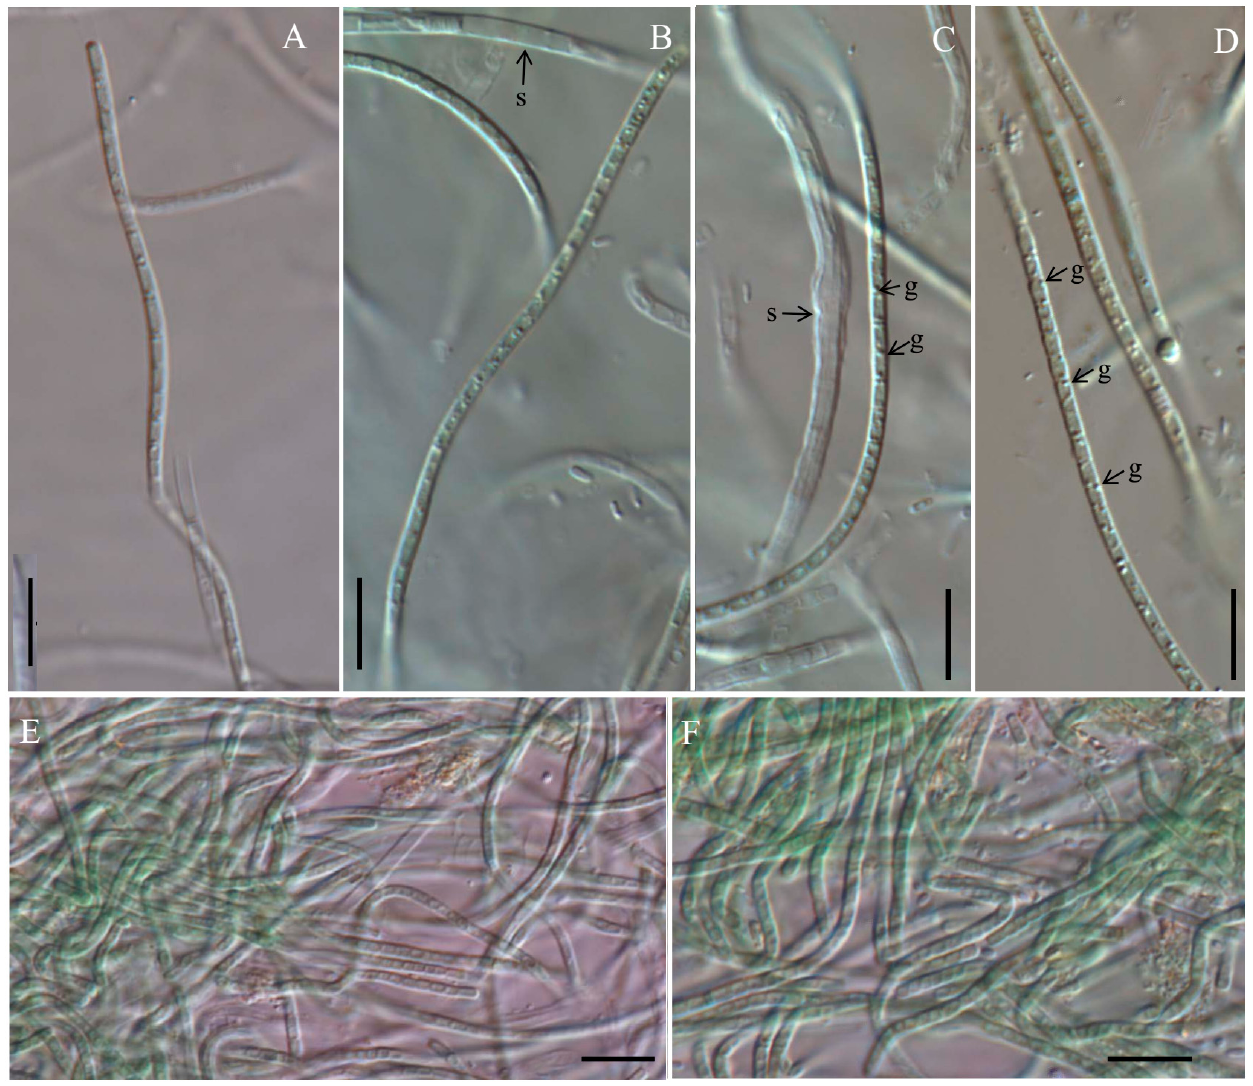
Figure 1. Micrographs of Cartusia hunanesis by light microscopy (LM): ( A , B , E ) Cartusia hunanesis ZJJ02; ( C , D , F ) Cartusia hunanesis ZJJ03. s: sheath, g: granules. Scale bar = 10 µm. Description: Colony spherical and blue-green, becoming yellow-green with age. Fila- ments straight or flexuous, freely entangled, without false branching, with only a single trichome in a sheath. Sheath thin, firm, colorless, occasionally widened. Trichomes not nar- rowing, not or slightly constricted at the cross-walls. Cells in young trichomes longer than ¯ wide, in mature trichomes shorter than wide, 0.82–2.81 µ m long (X : 1.47 ± 0.51 µ m) and ¯ 1.36–2.43 µ m wide (X : 1.83 ± 0.26 µ m), with large granules visible in the cell cross